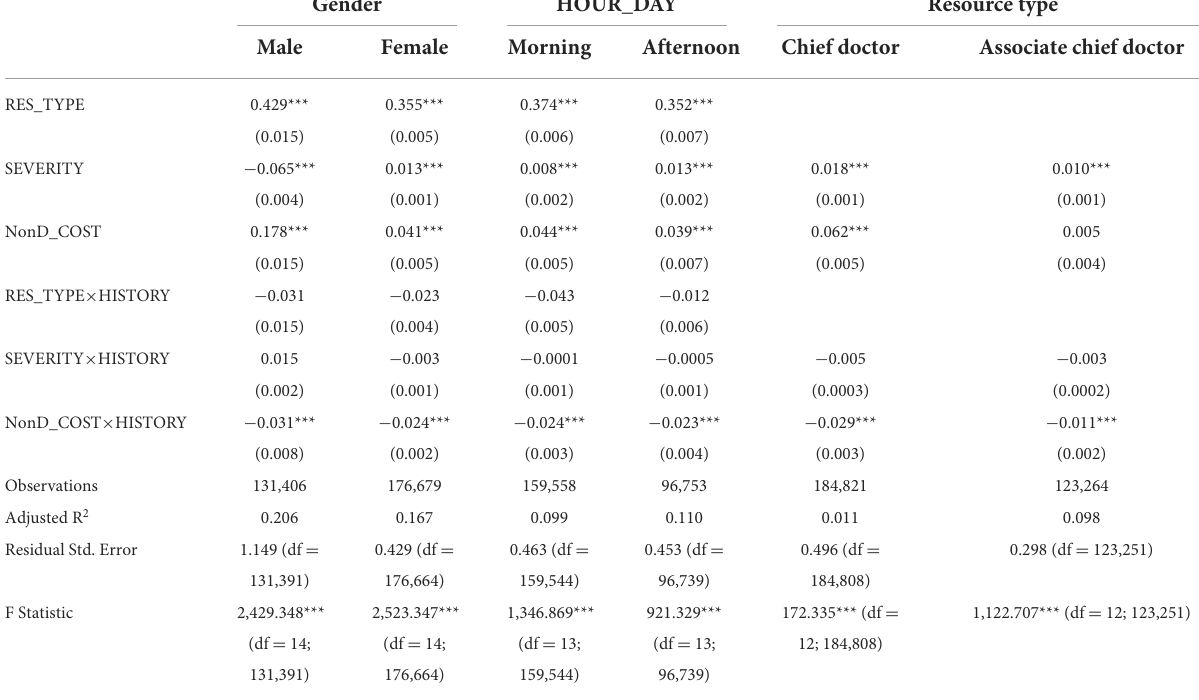
TABLE 7 Heterogeneity test results for appointment